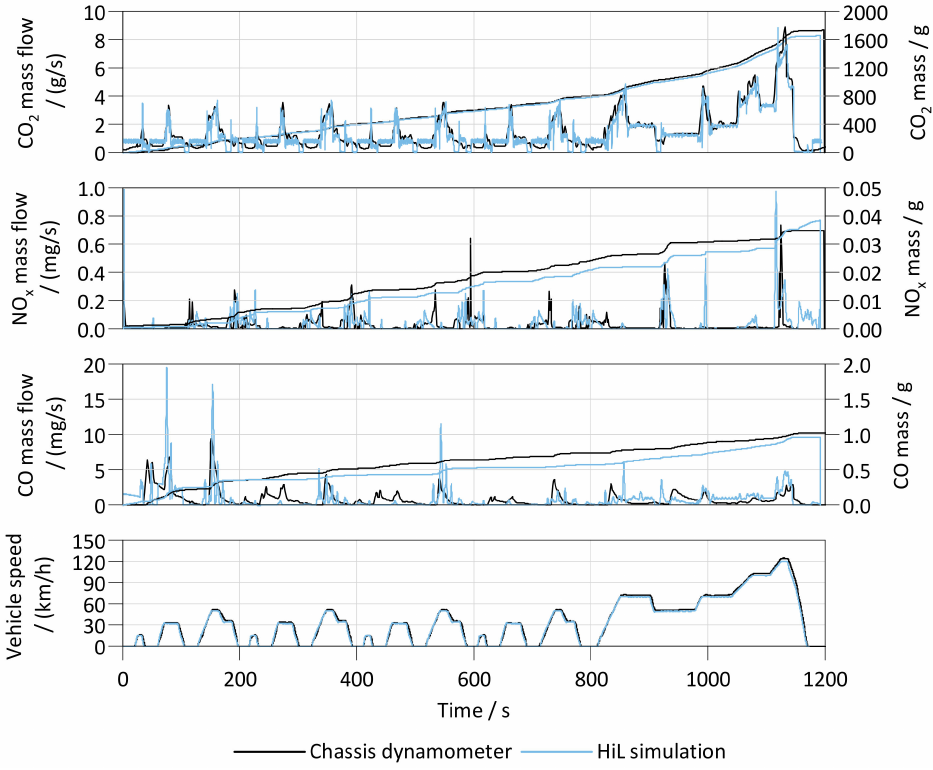
Figure 15. Comparison of real and HiL modeled NEDC emission